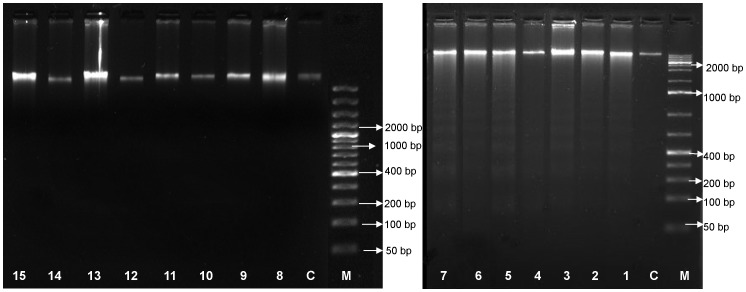
DNA fragmentation of HepG2 cells.DNA were isolated after incubation of HepG2 cells with 100 µM of fatty acid esters of phloridzin (Pz) in comparison with parent compounds phloridzin, free fatty acids, phloretin (aglycone) or liver cancer drug sorafenib for 24 h. Lane M: molecular-weight marker, lane C: control, lane 1–6: stearic acid ester of Pz, oleic acid ester of Pz, linoleic acid ester of Pz, α-linolenic acid ester of Pz, DHA ester of Pz and EPA ester of Pz, lane 7: sorafenib, lane 8–13: stearic acid, oleic acid, linoleic acid, α-linolenic acid, DHA and EPA, lane 14: phloridzin, and lane 15: phloretin. Shown are representative gel images of three independent experiments.